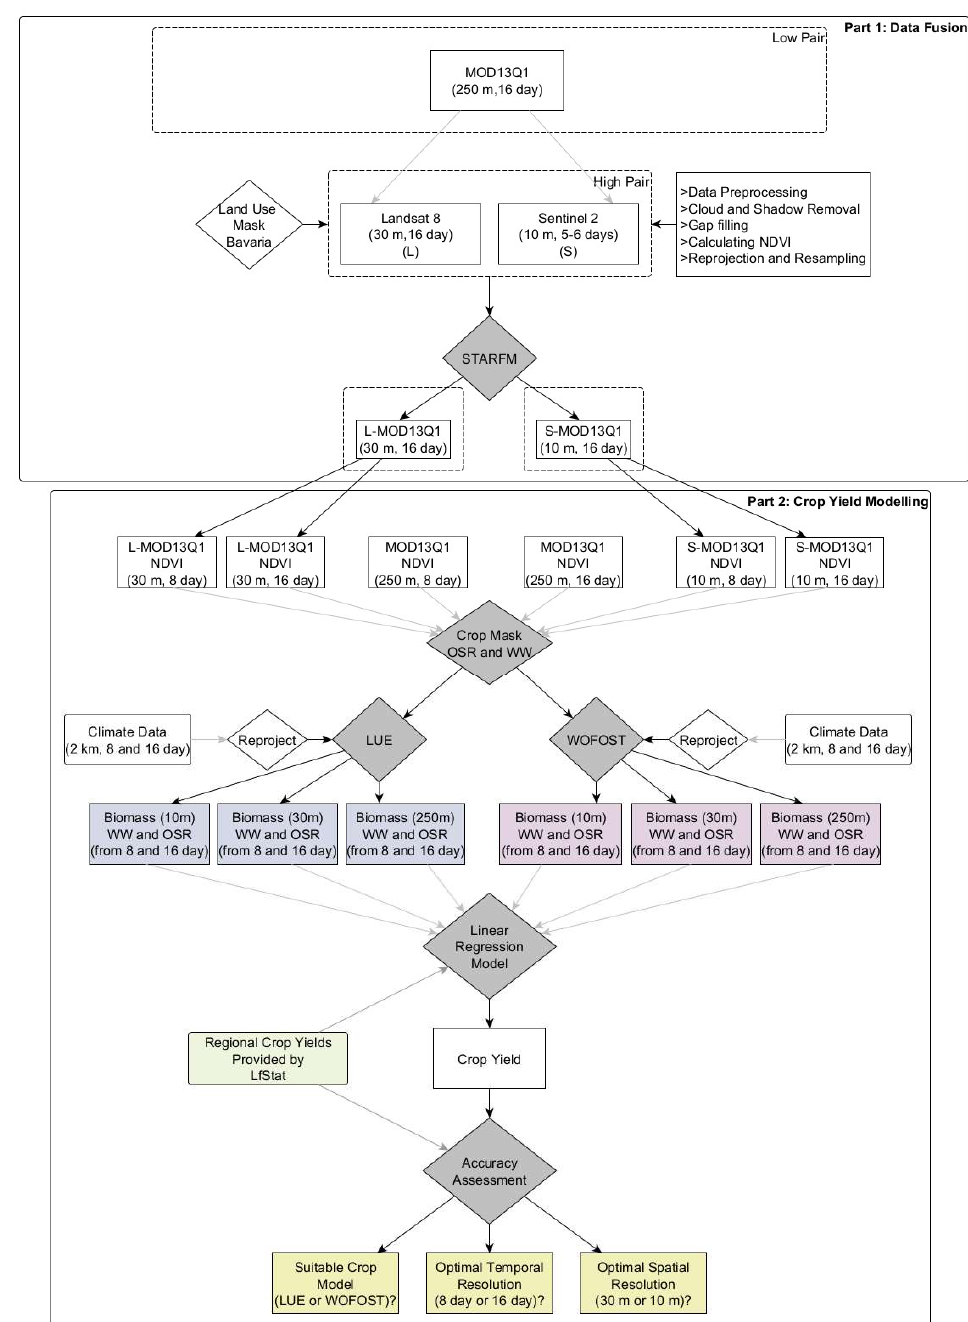
Figure 1. The conceptual framework of this study is divided into two parts: Part 1 states the data fusion for 2019 to investigate the synthetic NDVI time series product (this section was completed in our previous study [4]) and Part 2 estimates and validates the crop yield for Bavaria by inputting the fused L-MOD13Q1 time series and climate elements to a semi-empiric Light Use Efficiency (LUE) model. STARFM = Spatial and Temporal Adaptive Reflectance Fusion Model; NDVI = Normalised Difference Vegetation Index; L-MOD09GQ = Landsat-MOD09GQ; L-MOD09Q1 = Landsat-MOD09Q1; L-MCD43A4 = Landsat-MCD43A4; L-MOD13Q1 = Landsat-MOD13Q1; S-MOD09GQ = Sentinel-2-MOD09GQ; S-MOD09Q1 = Sentinel-2-MOD09Q1; S-MCD43A4 = Sentinel-2-MCD43A4; S-MOD13Q1 = Sentinel-2-MOD13Q1; LfStat = the Bayerisches Landesamt für Statistik